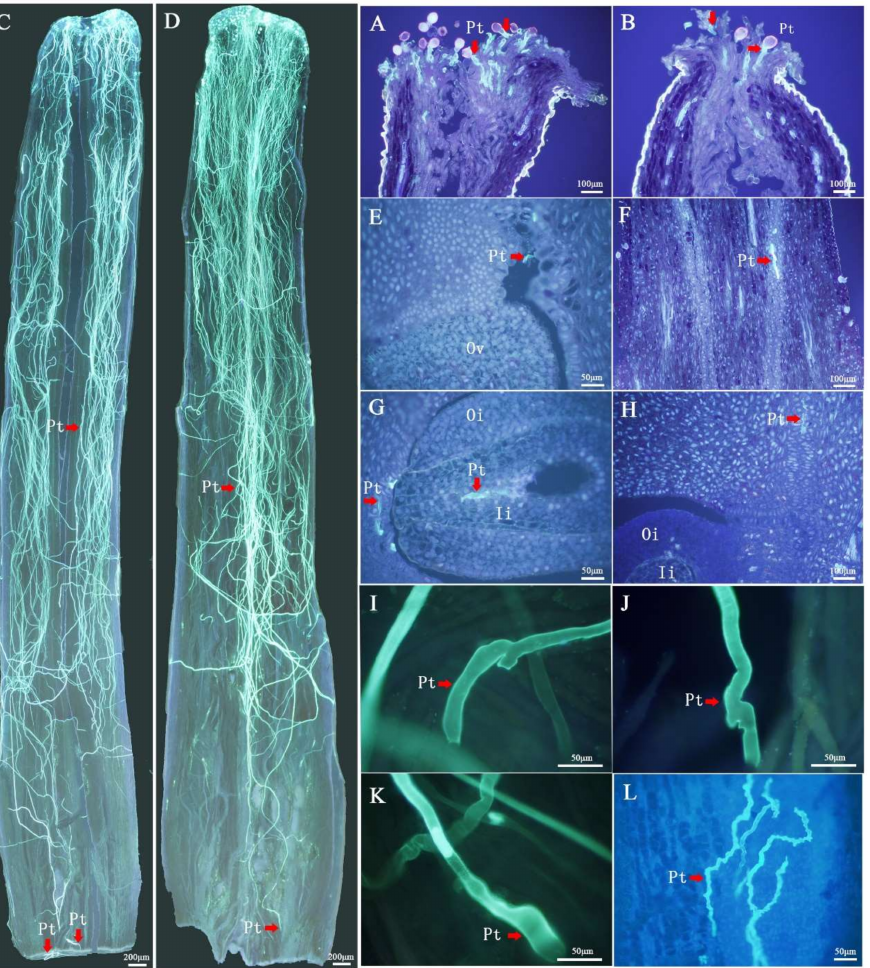
Figure 1. Pollen tube growth from 2 h to 72 h in the pistil after self- and cross-pollination in Camellia oleifera . ( A ) Pollen grain germination on stigma at 2 h after cross-pollination (CP) (100 × ). ( B ) Pollen grain germination on stigma at 2 h after self-pollination (SP) (100 × ). ( C ) Pollen tube growth to the base of the style at 48 h after CP (40 × ). ( D ) Pollen tube growth to the base of the style at 48 h after SP (40 × ). ( E ) Pollen tube growth to the upper part of ovary at 48 h after CP (200 × ). ( F ) Pollen tube growth to ovary at 48 h after SP (100 × ). ( G ) Pollen tube growth to ovule at 72 h after CP (200 × ). ( H ) Pollen tube growth to ovary at 72 h after SP (100 × ). ( I – K ) Abnormally shaped pollen tubes at the base of style after SP. ( L ) Abnormally shaped pollen tube at the upper part of ovary after SP. Pt = pollen tube, Es = embryo sac, Oi = outer integument and Ii = inner